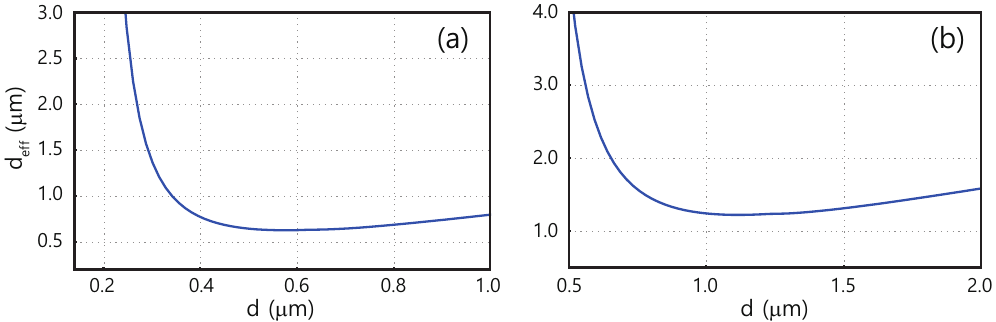
Figure 11. Effective diameters of the fundamental modes as a function of diameter ( a ) at λ = 780 nm and ( b ) at 1.5 µ